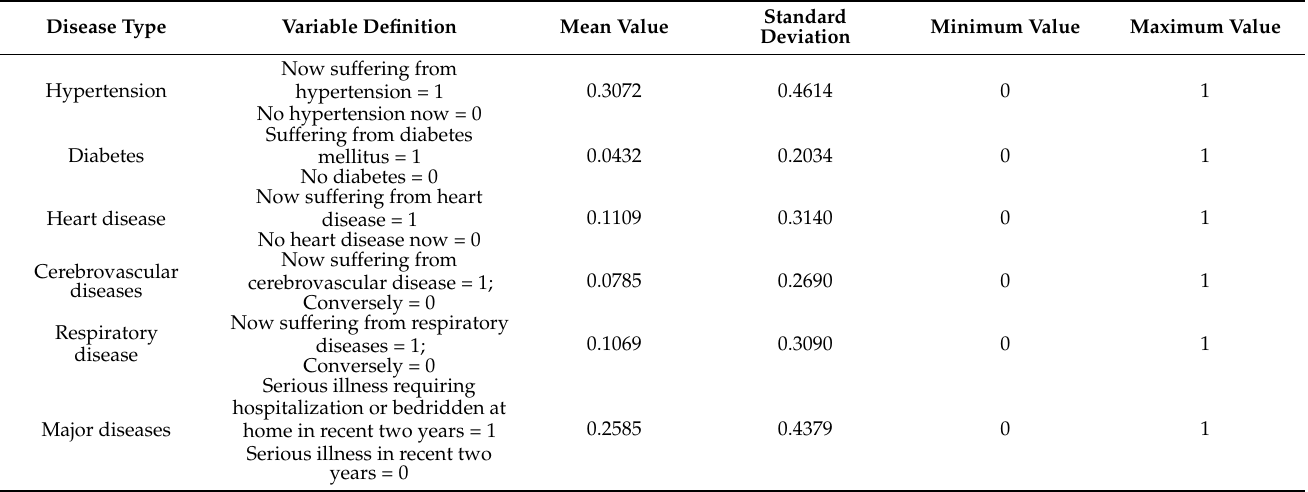
Table 4. Definition and description of disease type variables and statistical